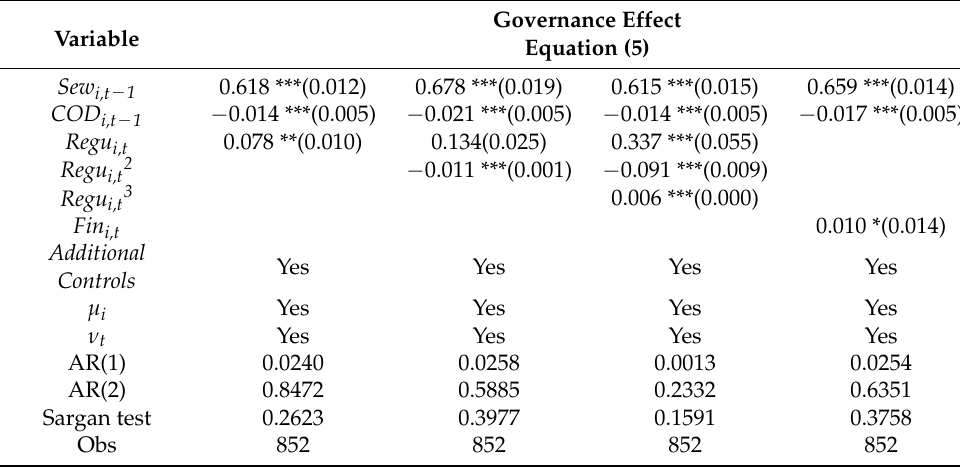
Table 4. The governance effect of local government behavior.